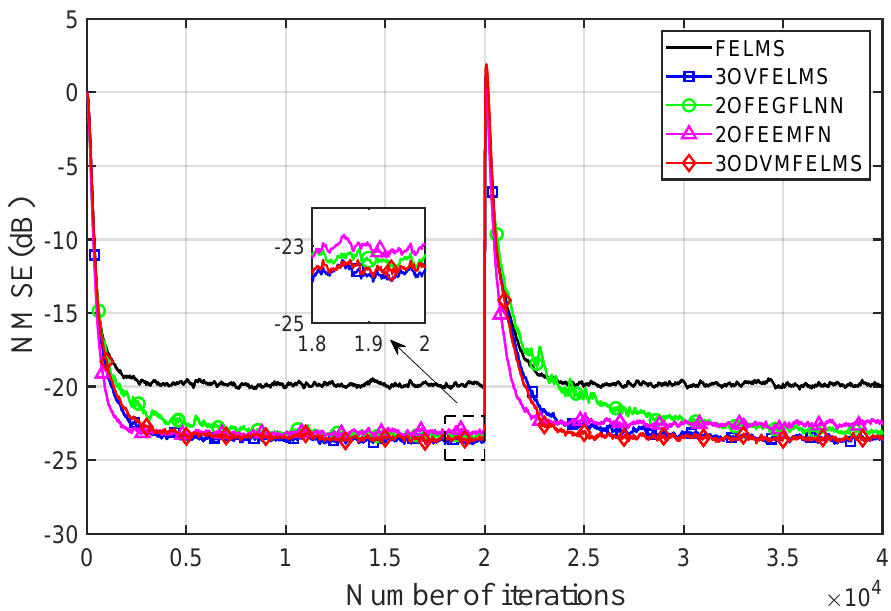
Figure 5. Performance comparison using the nonlinear primary path with band-limited white Gaussian reference signal.